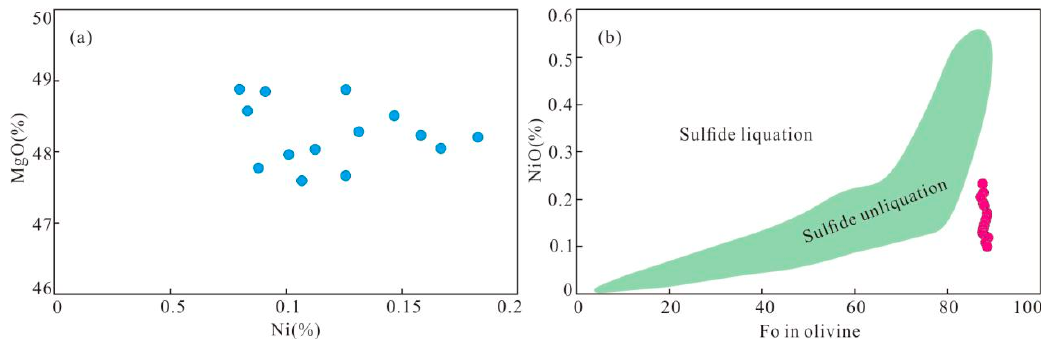
Figure 15. Diagrams of olivine. ( a ) Ni-MgO showing the discrete relationship between Ni and MgO; ( b ) Fo-NiO showing the sulfide liquation.